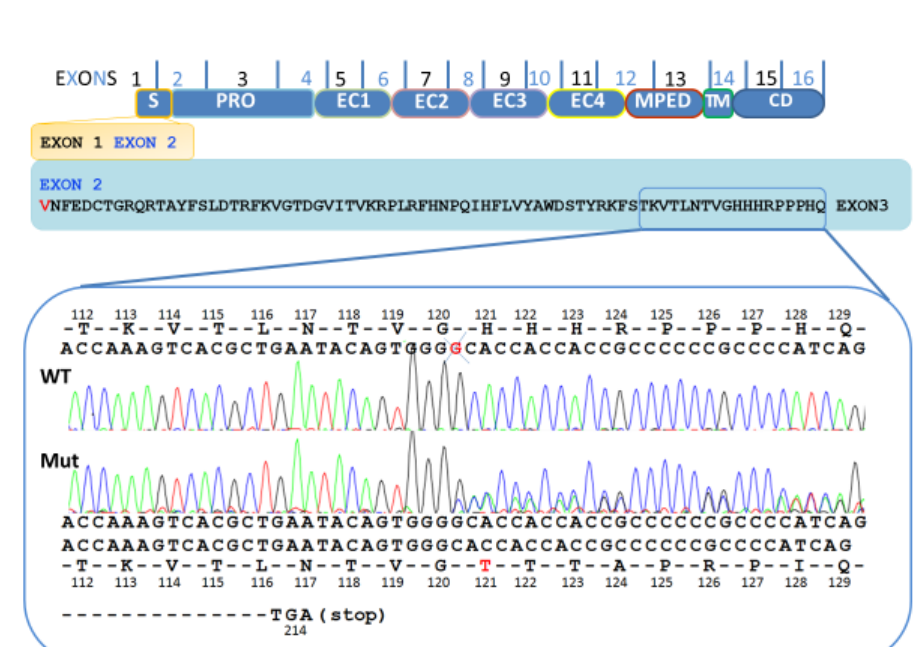
Figure 2. Schematic representation of the different domains of E-cadherin: signal peptide (S), precursor sequence (PRO), extracellular domains (EC1, EC2, EC3, EC4), membrane-proximal extracellular domain (MPED), transmembrane domain (TM) and a cytoplasmic domain (CD). Electropherogram of the CDH1 variant gene in exon 3 (p.His121Thrfs*94), resulting in the new reading frame (94 codons up to and new stop codon (214)). Top: partial CDH1 exon 3 wildtype (WT) sequence; bottom: the parallel CDH1 exon 3 sequence from the patient’s DNA with the deletion of G (Mut).